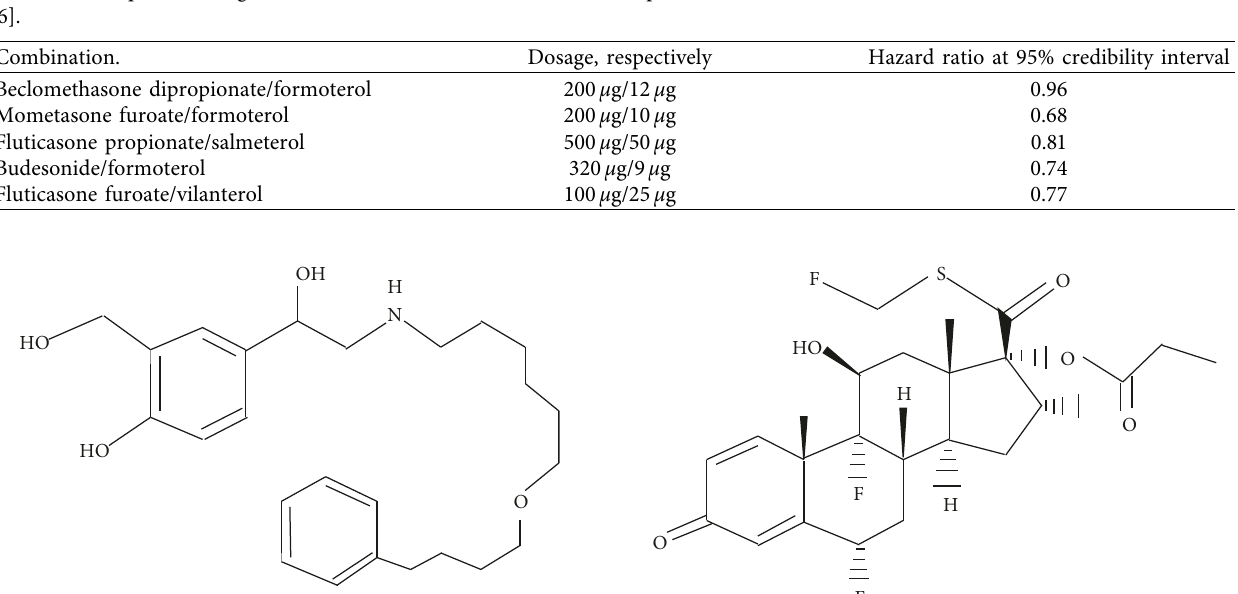
Figure 1: Chemical structure of salmeterol.